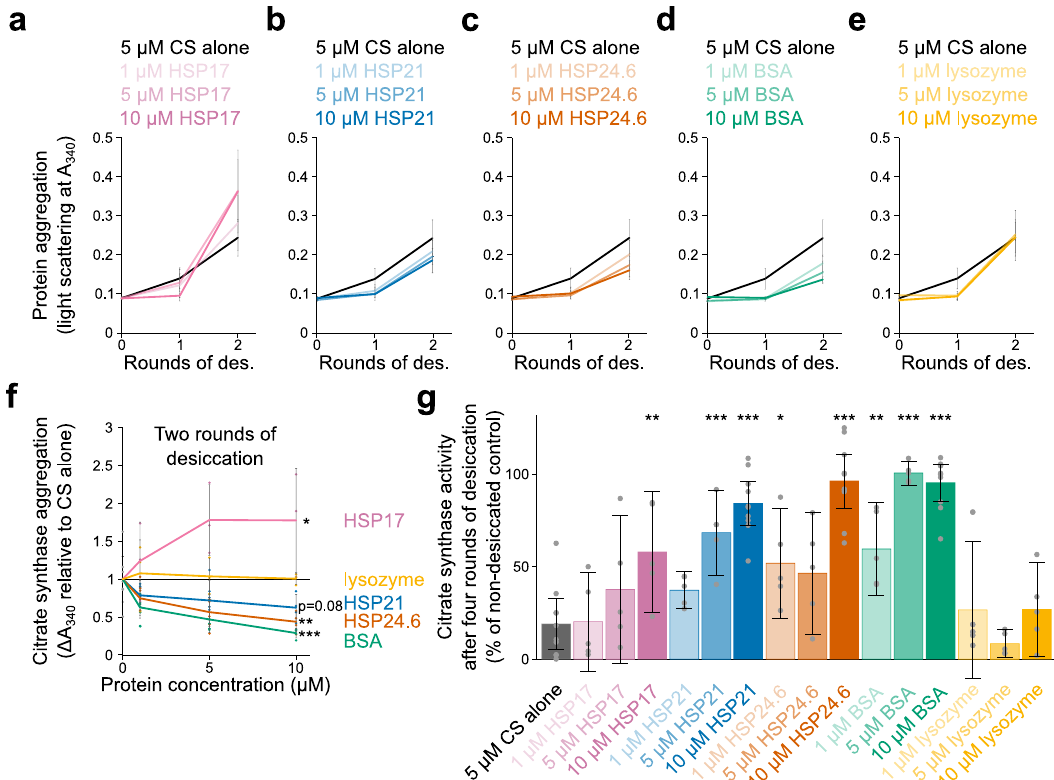
Fig. 5 HSP21 and HSP24.6 limit desiccation-induced protein aggregation. Light scattering (A 340 ) values indicate aggregation of 5 µ M citrate synthase over two rounds of desiccation and rehydration and the effects of adding HSP17 ( a ), HSP21 ( b ), HSP24.6 ( c ), BSA ( d ), or lysozyme ( e ). f After two rounds of desiccation and rehydration, the change in A 340 across a range of concentration of additives showed an effect of concentration on aggregation for HSP17 ( p = 0.03, 1-way ANOVA, n = 3 – 9), HSP24.6 ( p = 0.003, 1-way ANOVA, n = 4 – 9), and BSA ( p < 0.001, 1-way ANOVA, n = 4 – 9). g Citrate synthase was protected from desiccation-induced loss of function when supplemented with 10 µ M HSP17 ( p = 0.009), 5 µ M HSP21 ( p < 0.001),10 µ M HSP21 ( p < 0.001),